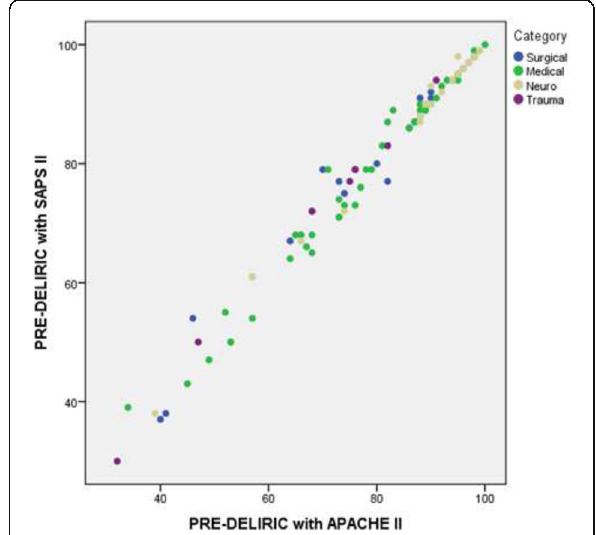
Fig. 2 (abstract 0034). ICC PRE-DELIRIC SAPS II - PRE-DELIRIC APACHE II